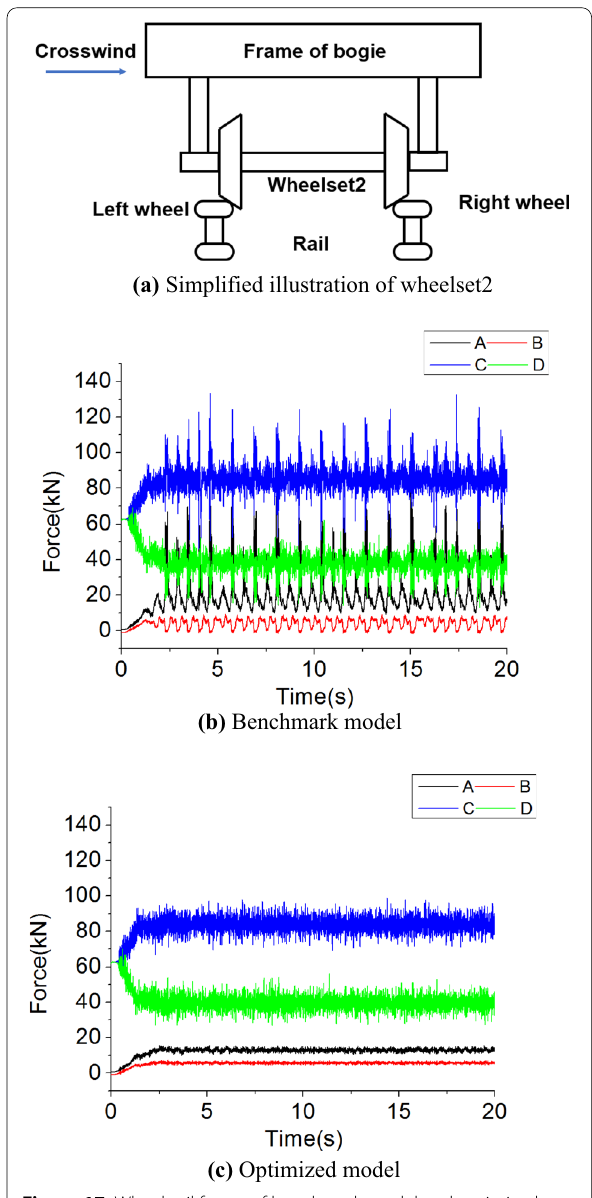
Figure 17 Wheel-rail forces of benchmark model and optimized